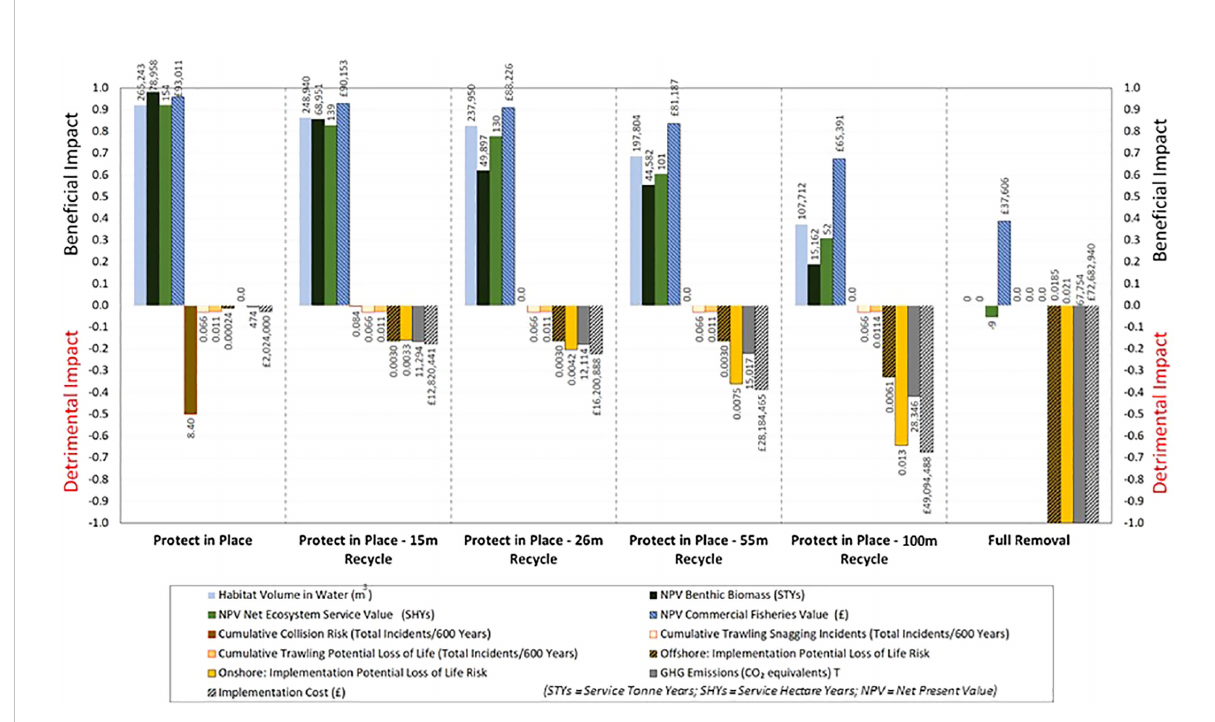
FIGURE 4 Bene fi cial and Detrimental Trade-offs Associated with the Jacket and the Protect-In-Place Recycle